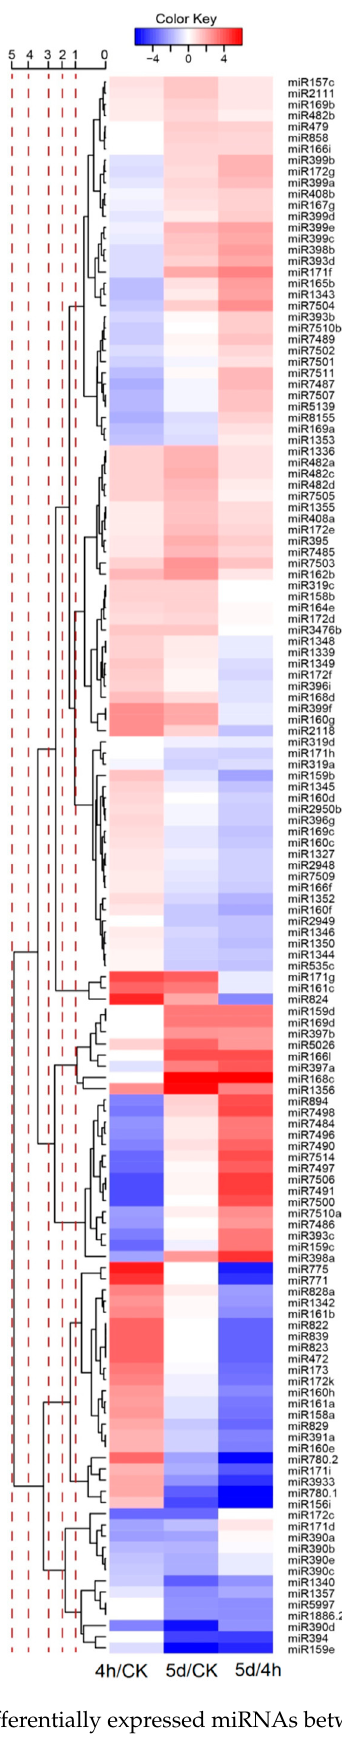
Figure 2. Differentially expressed miRNAs between libraries.